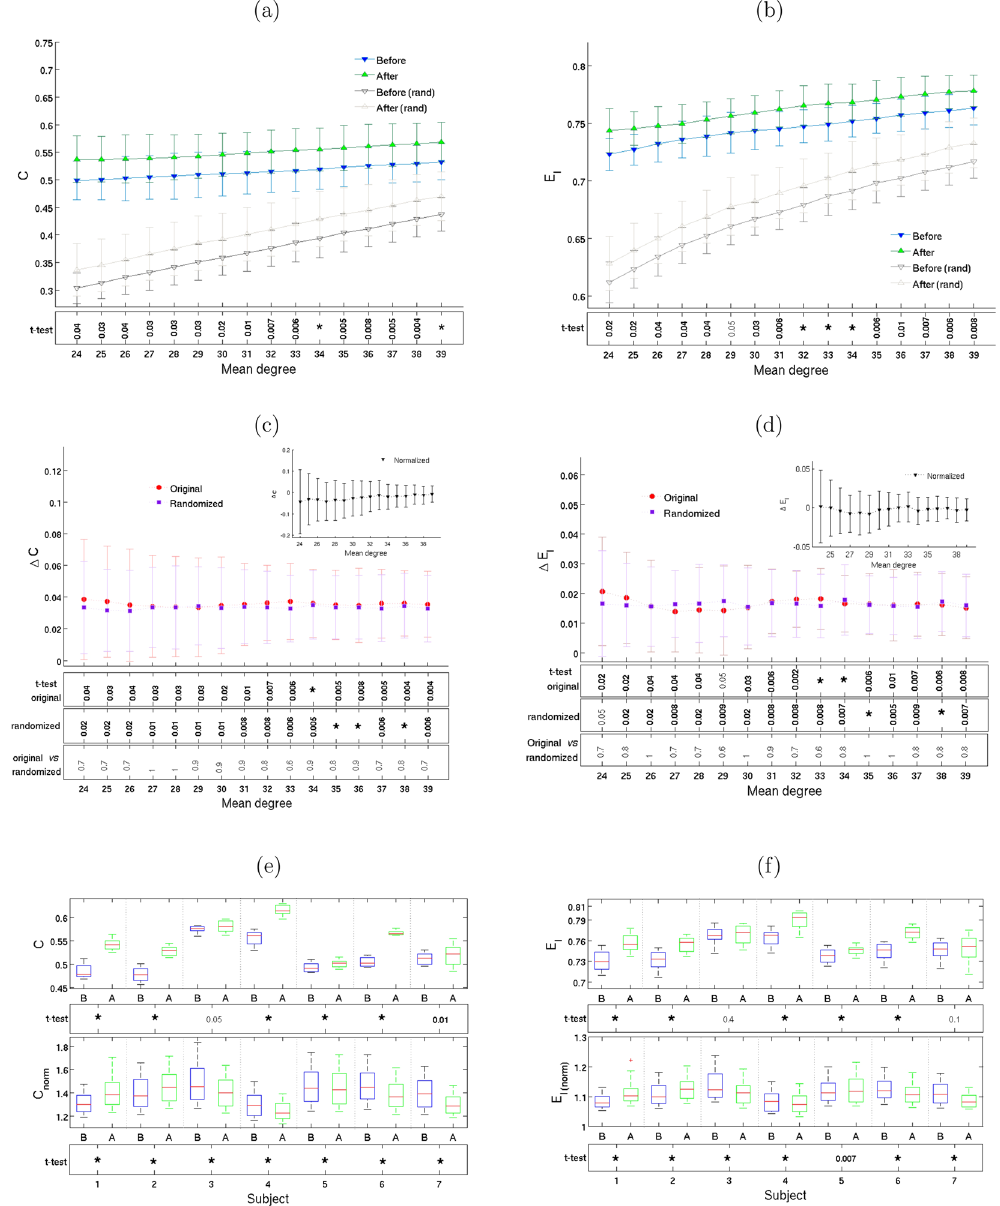
Figure 6. Local efficiency and integration increase. Clustering coefficient C (right column) and local efficiency E l (left column). Plots ( a ) and ( b ) show means ± 1 standard deviations, calculated from the complex networks of all 7 subjects, as well as from their corresponding iso-entropic randomized networks, for 16 different mean degrees. Plots ( c ) and ( d ) show the change in C and E l after Ayahuasca ingestion. The inset shows normalized values (see text). Boxplots ( e ) and ( f ) show the same information, subject-by-subject. As before, the rows below the plots show p -values for the t -test, with asterisks ( * ) indicating p <